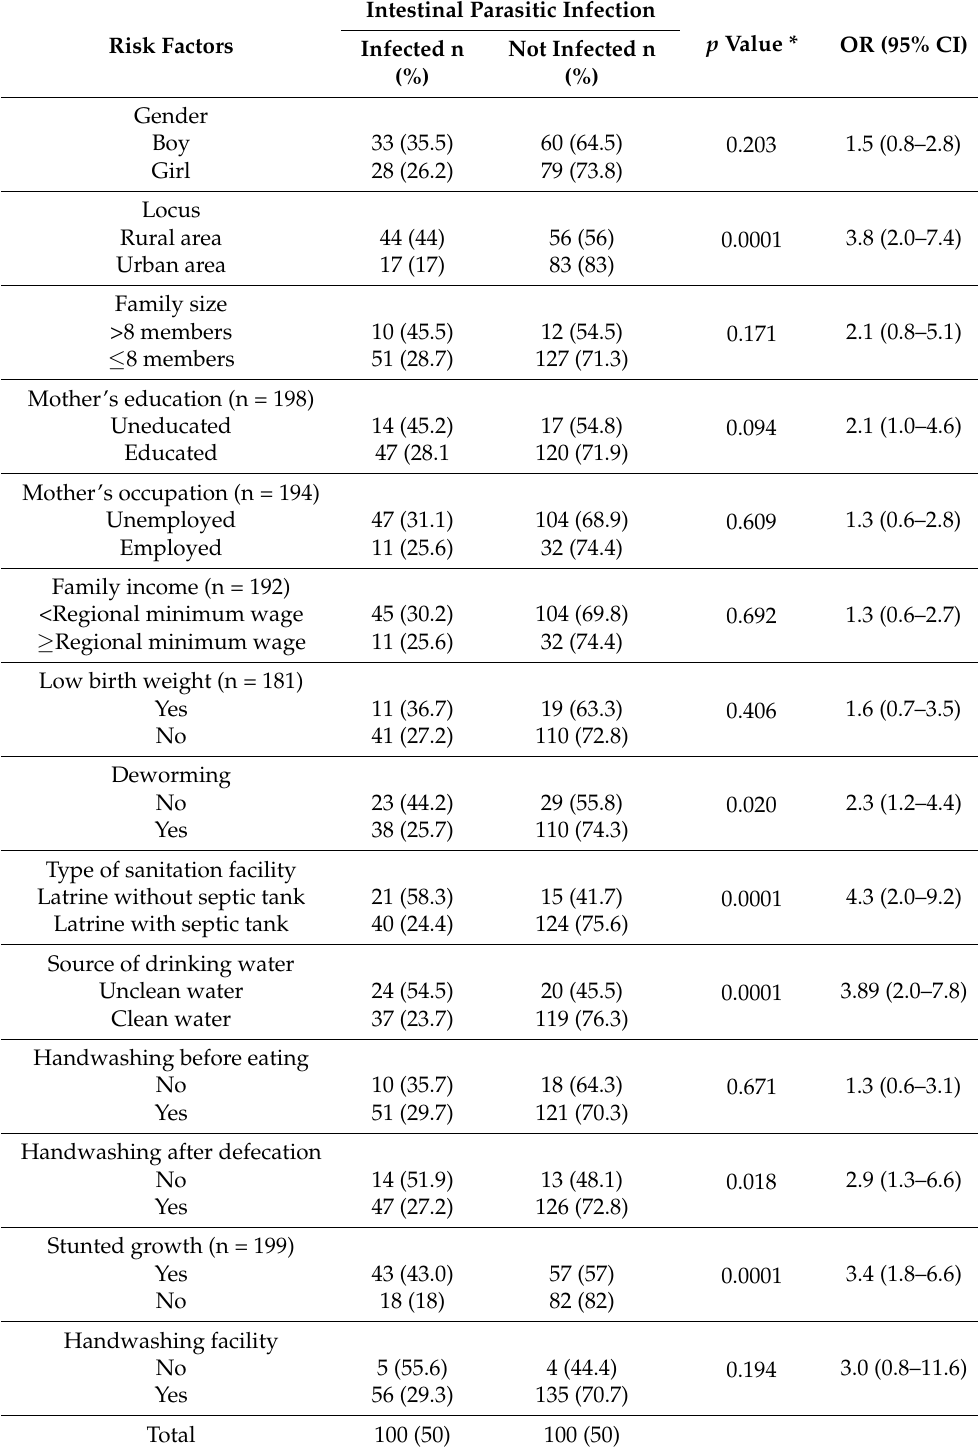
Table 1. Univariate analysis of intestinal parasitic infection risk factors among children